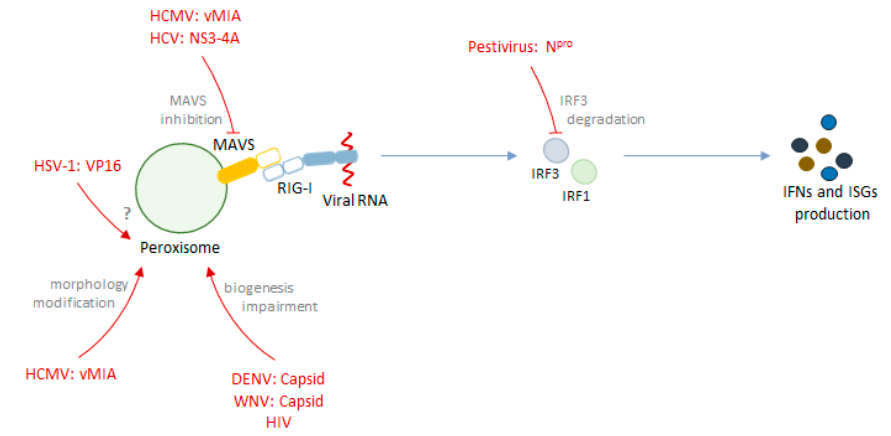
Figure 2. Schematic representation of the interplay between di ff erent viruses and the peroxisome-dependent antiviral signaling.